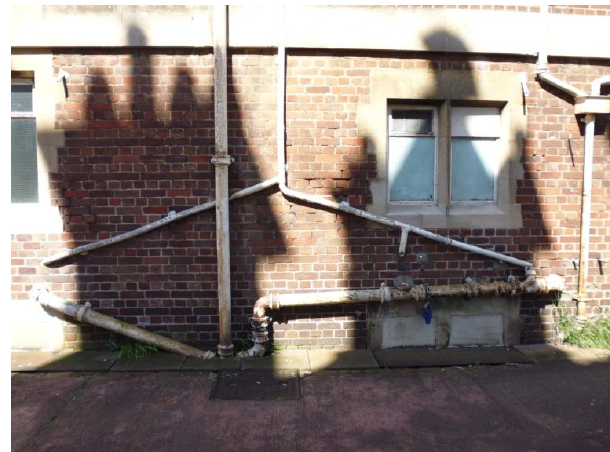
Figure 1. Shadows. Figure 1.